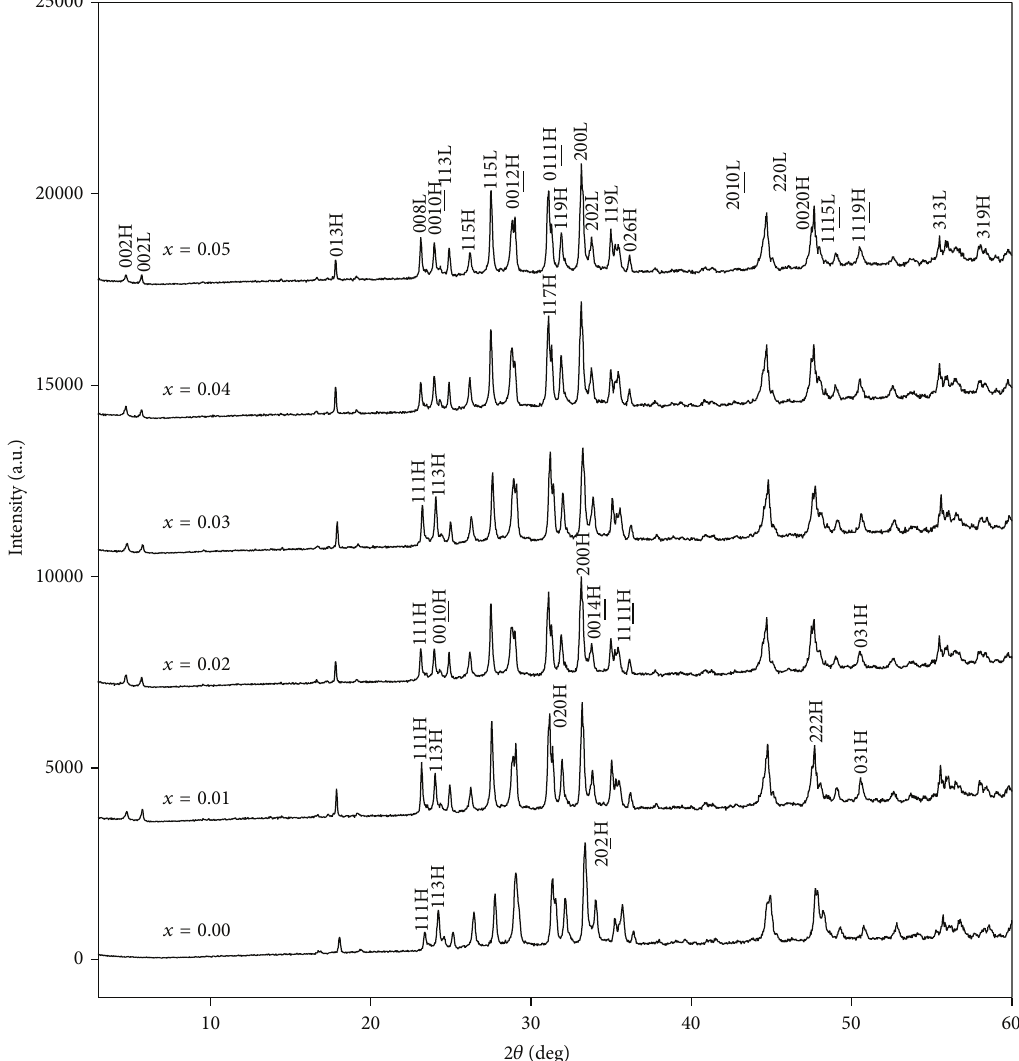
Figure 2: XRD patterns of the nonadded and 10nm Co 3 O 4 added Bi-2223 samples. (H) denotes the high- 𝑇 𝑐 phase (Bi-2223) and (L) denotes the low- 𝑇 𝑐 phase